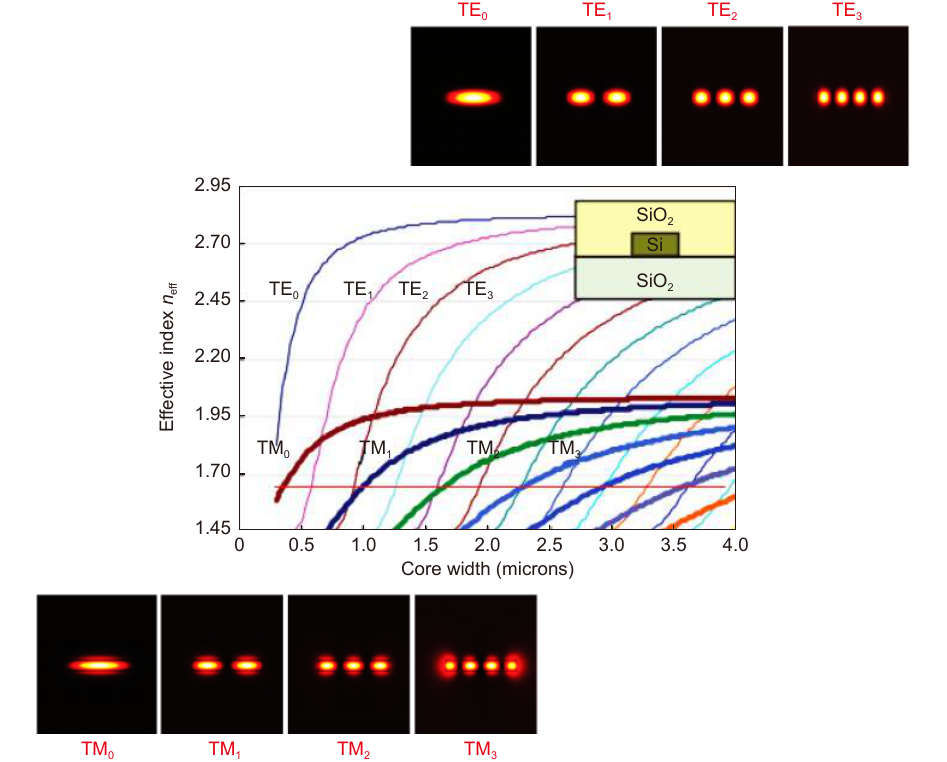
Fig. 9 | Effective refractive indices of the guided modes versus width of the core width. Inset shows the mode shapes of the fundamental and higher-order modes. Figure reproduced with permission from ref. 88 , under a Creative Commons Attribution 4.0 International License.